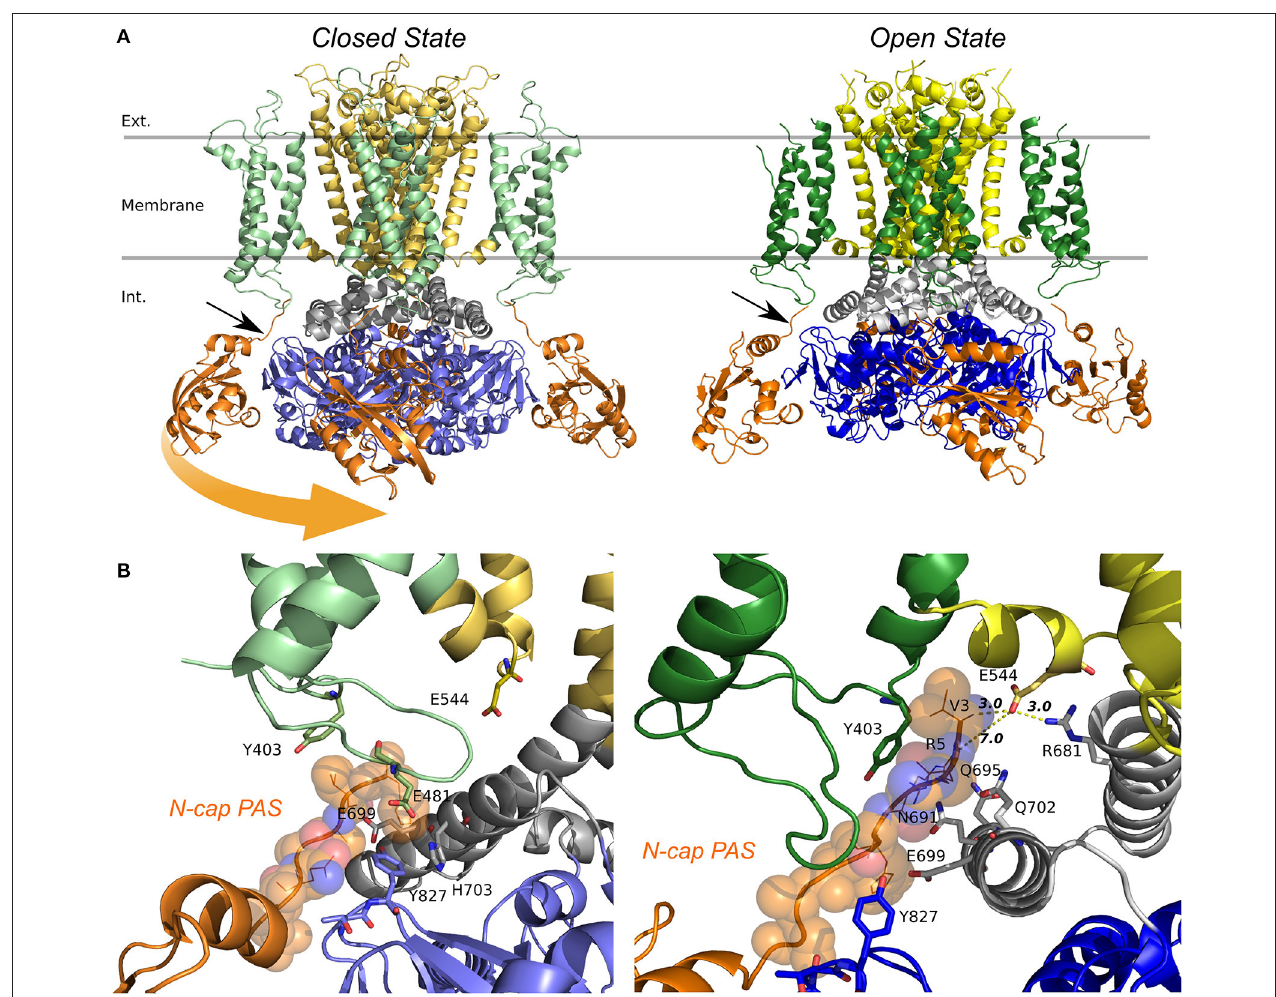
FIGURE 9 | Models of the quaternary structure of homomeric hERG tetramers. Side view (A) of closed state model in the left panel and open state hERG Cryo-EM structure, right panel. In both structures N-cap PAS can be seen interacting with VSD (black arrow). When the TM domain is aligned, cytoplasmic domains are slightly rotated respects each other. Orange arrow show the rotation direction when transitioning from closed to open states. (B) N-cap PAS interaction with VS (S1 & potentially S4-S5), CNBD, and C-linker for closed in the left panel and open states, right